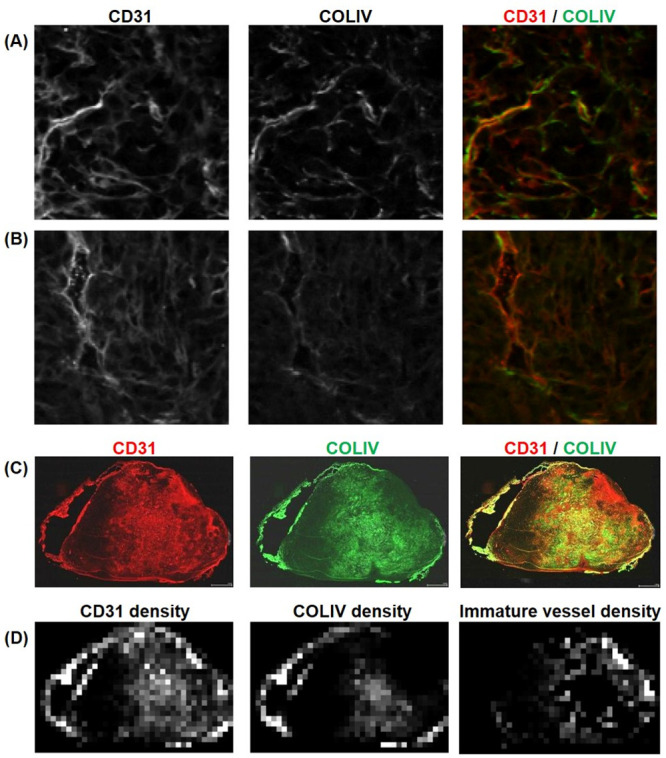
Quantification of immature vessels that lack COLIV staining for basement membrane.(A) A representative patch (500 x 500 pixels; 0.2 x 0.2 mm2) with vessels stained positive mostly for both CD31 and COLIV, which has a high covariance between the two staining density maps. (B) A representative patch with vessels that has strong staining for CD31, but weak staining for COLIV. This case has a lower covariance between the two staining density maps. (C) The whole slice CD31 and COLIV stained images for a case in the control group. (D) The CD31 and COLIV density maps estimated from the corresponding IHC images shown in (C). The immature vessel density map shown in the last column was generated using the stain covariance map between CD31 and COLIV as a mask to show CD31 densities only for the patches with low covariances.